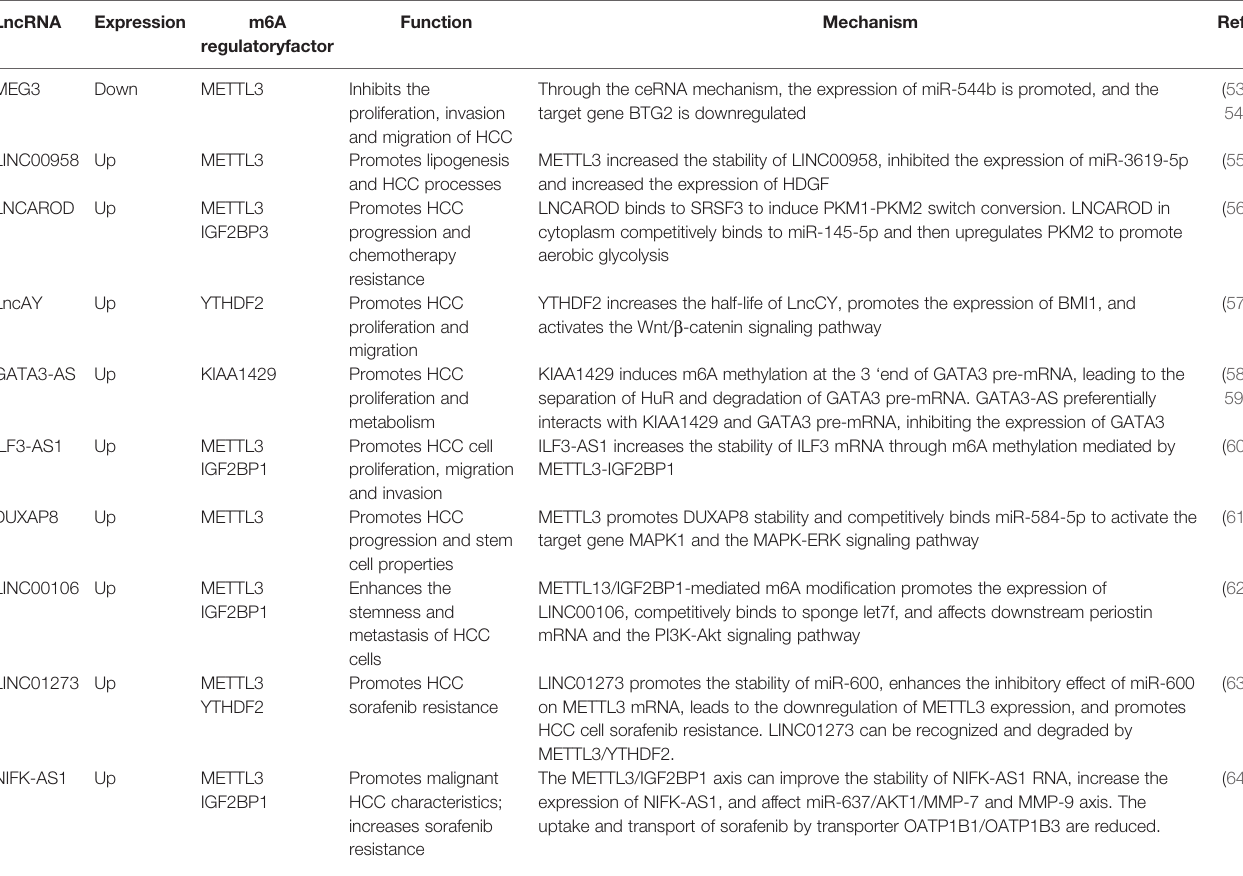
TABLE 2 | The mechanism of m6A regulatory factors and their in fl uence on HCC.